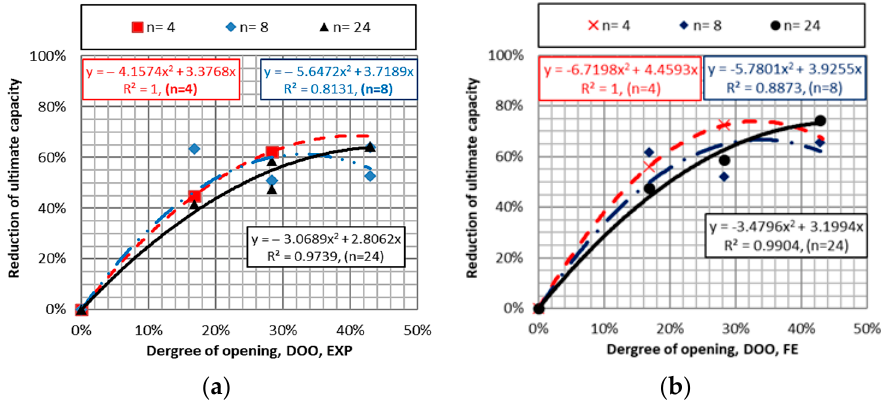
Figure 16. Capacity reduction as a function of DoO for different opening numbers, EXP ( a ) and FE ( b